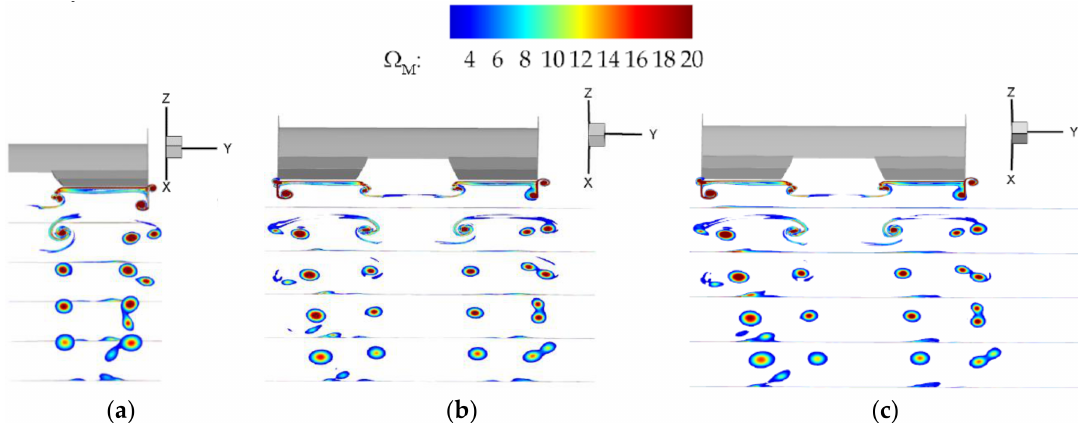
Figure 29. Contours showing the mean vorticity magnitude at several transverse locations ranging from x Wi /c = 1.019 and x Wi /c = 3.704; the colour contour limits have significantly been decreased compared to previous figures to aid visualization. ( a ) Straight-line condition ( b ) Cornering condition; ( c ) Fixed yaw